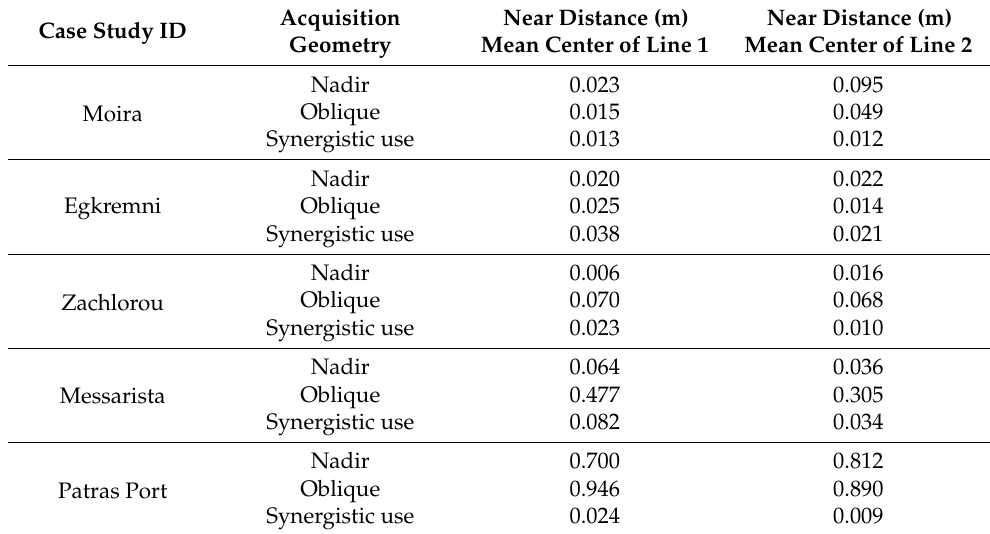
Table 4. Near distances of mean centers resulting from the reference mean centers of geodetic lines 1 and 2.